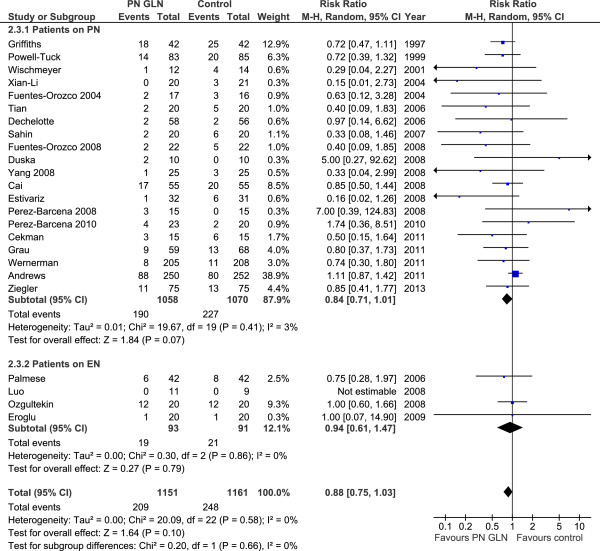
Overall mortality.